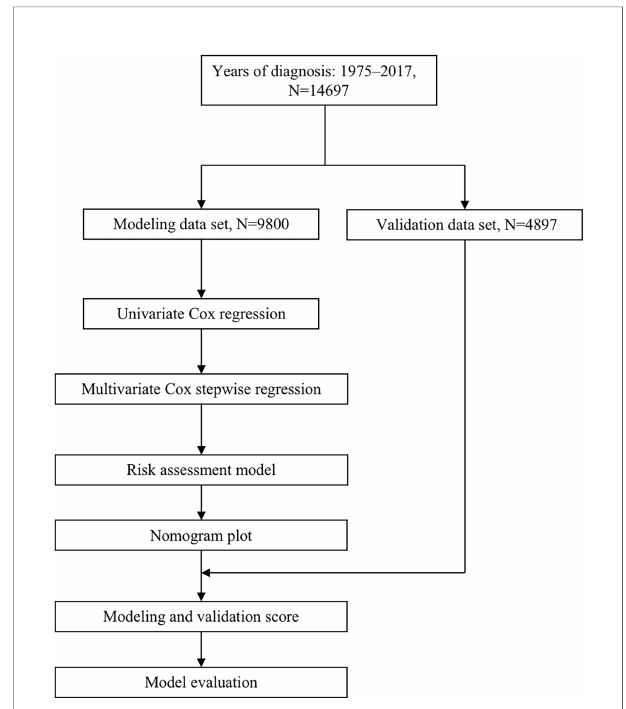
FIGURE 1 | Flow diagram for predicting OS of CLM patients. OS, overall survival; CLM, colon cancer liver